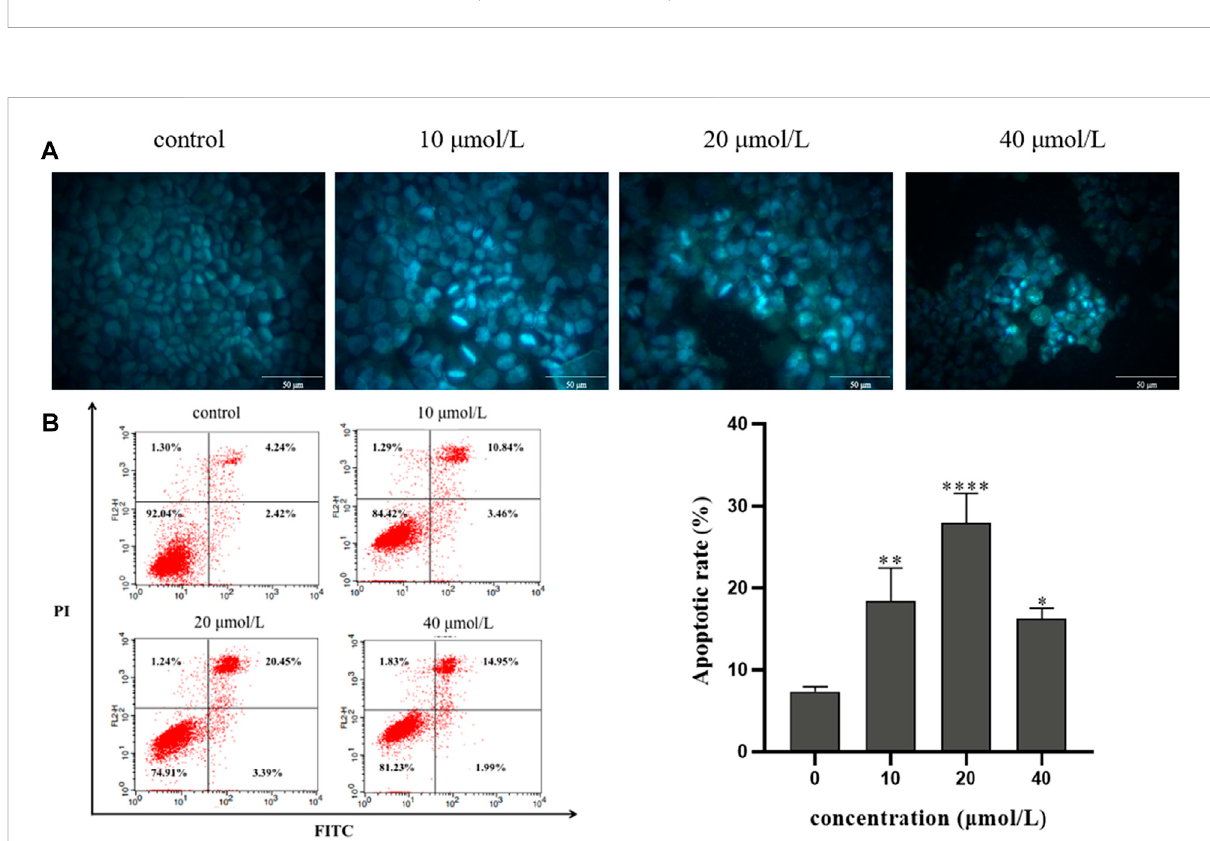
nuclear membrane, and the bright blue apoptotic body could be observed. The above are typical manifestations of apoptosis (Figure 4A).